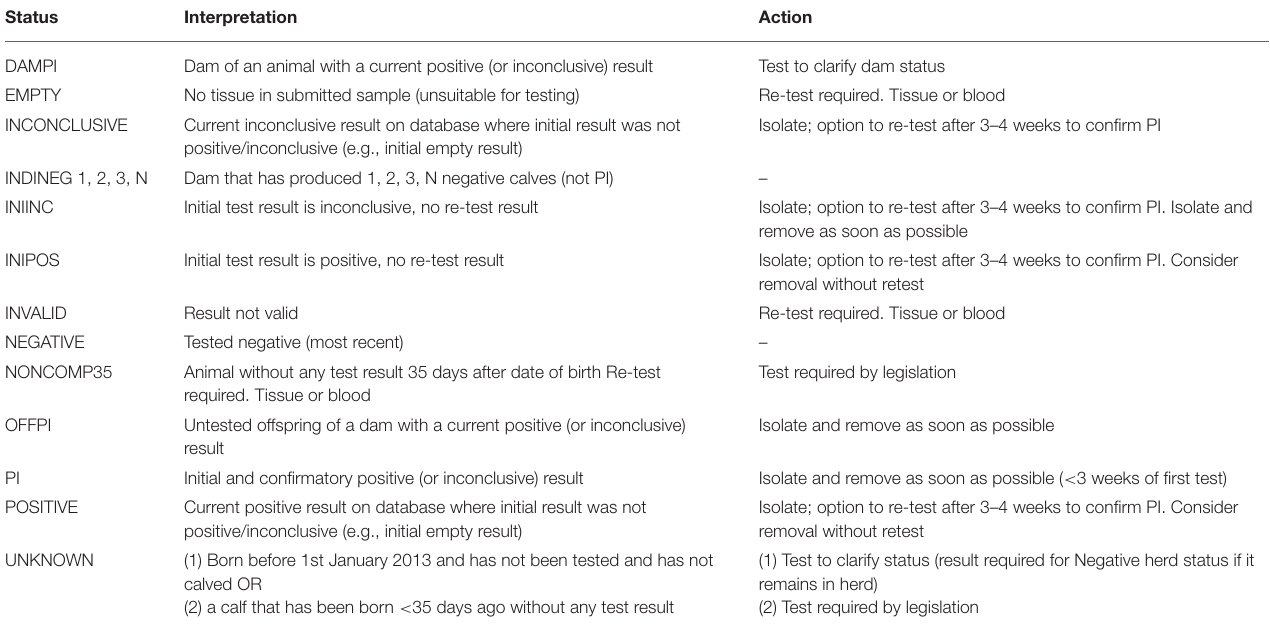
TABLE 1 | Summary of the 13 possible statuses assigned to each animal in the programme database in relation to its BVD status, and the interpretation and action recommended with each one.